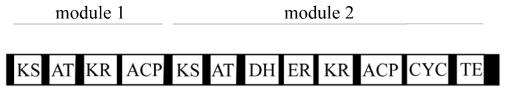
Organization of a putative gene cluster encoding a Type I PKS subunit. The programming of complex polyketides is achieved by discrete modules containing multiple catalytic domains. Adapted from [59,60,66].